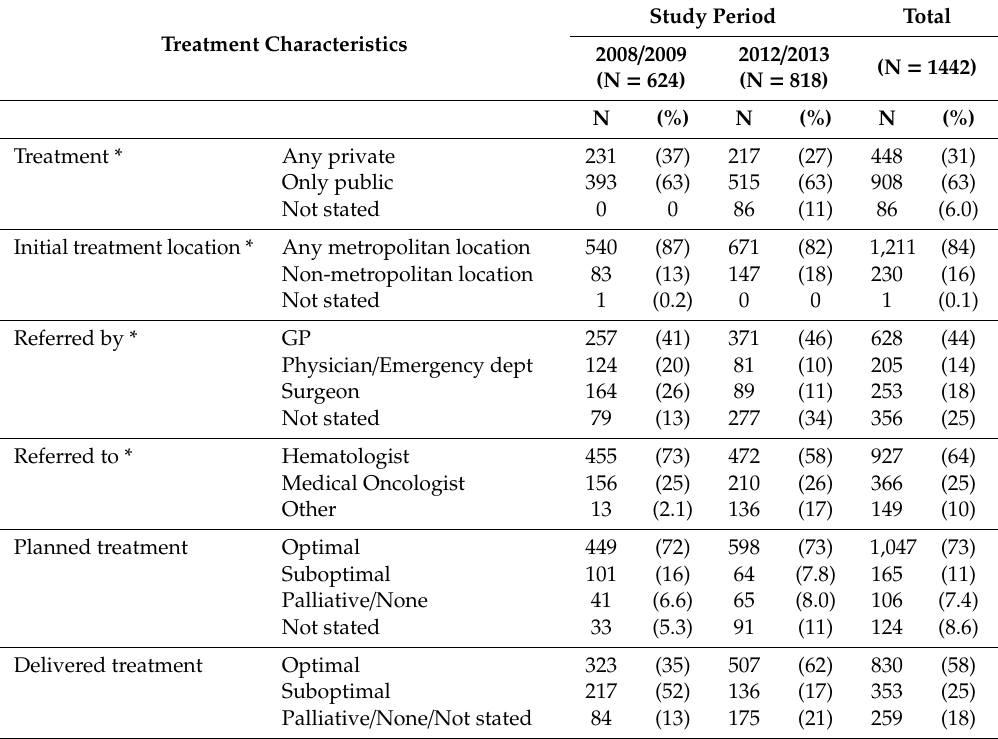
PD—progressive disease, SD—stable disease. Table 2. Characteristics of treatment including referral pathways, type of treatment cancer and planned and delivered care overall and across study